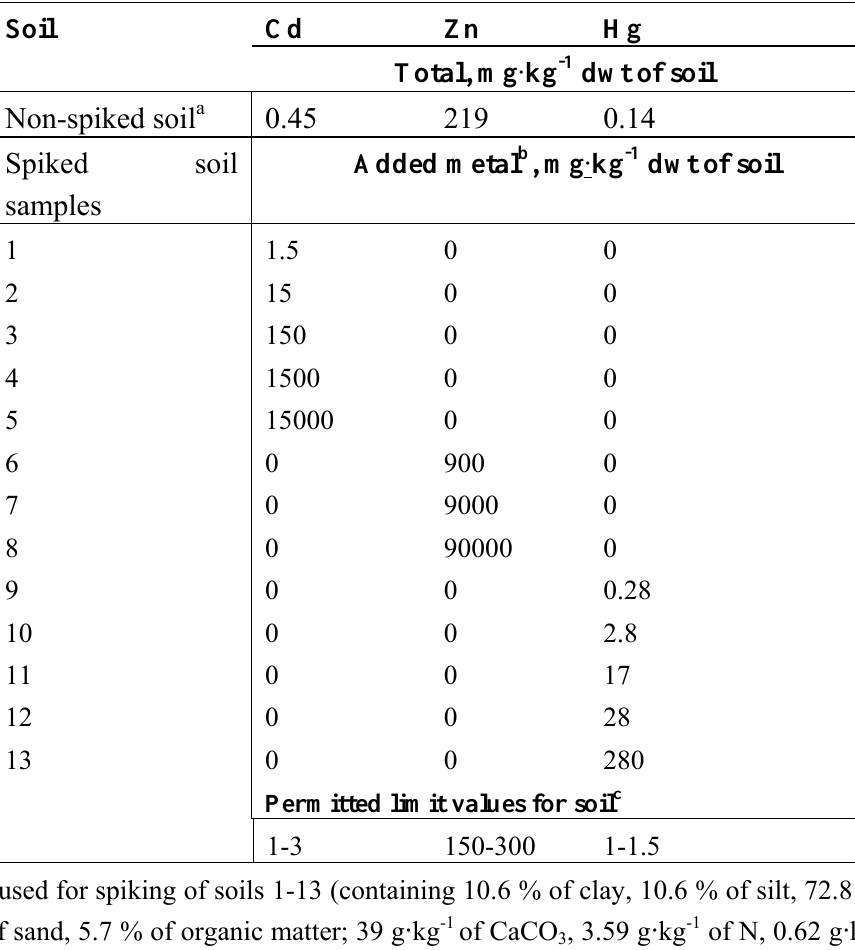
Table 4. Heavy metal concentrations in the soil and spiked